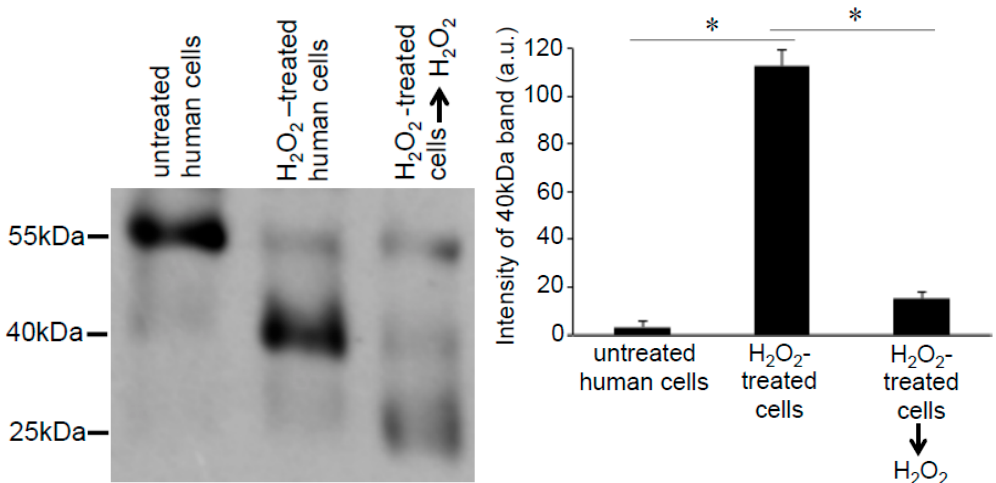
Figure 4. E ff ects of H 2 O 2 on thiol state of human Prx6 in cell lysates monitored using Protein-SHifter Plus. Cell lysates were prepared from untreated human pulmonary artery smooth muscle cells (Lane 1) or cells treated with H 2 O 2 for 15 min (Lane 2). Lysate proteins from H 2 O 2 -treated cells were denatured with SDS and incubated with H 2 O 2 (1 mM) in a test tube for 15 min (Lane 3). Protein-SHifter Plus was then added and the samples subjected to SDS-PAGE without BME and immunoblotted with the Prx6 antibody. The bar graph represents the means ± SEM of the intensity of the 40 kDa bands ( n = 3). The symbol * represents the value significantly different from each other at p < 0.05.